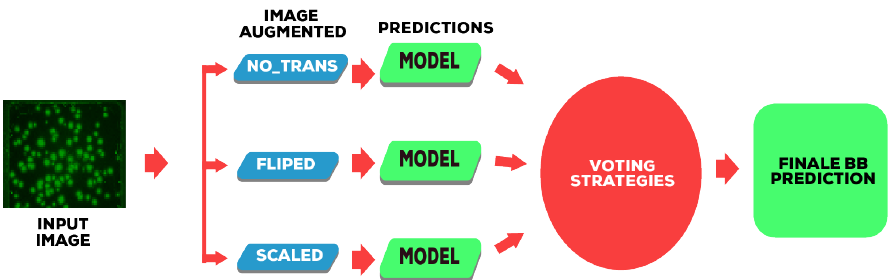
Figure 10. Workflow of TTA ensemble algorithm. Three methods have been applied to detect the objects in the original